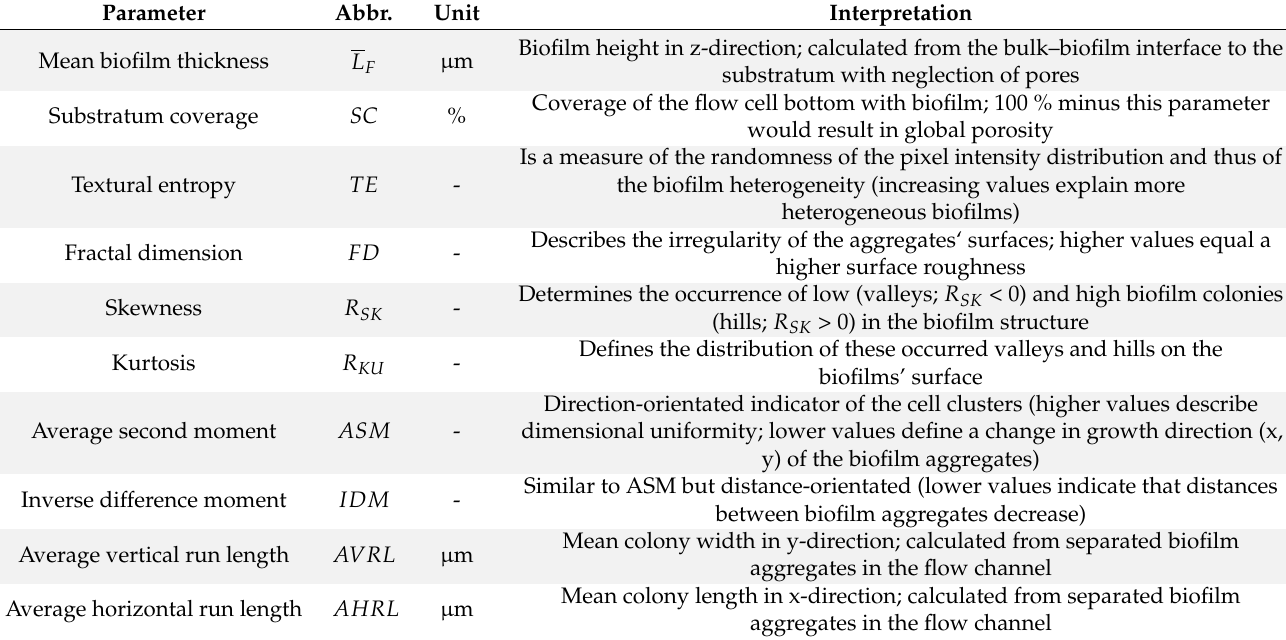
Table 2. Overview of all structural parameters used as well as their abbreviation, unit and interpreta- tion. Abbreviations: substratum coverage ( SC ), mean biofilm thickness ( L F ), textural entropy ( TE ), kurtosis ( R KU ) , skewness ( R SK ), fractal dimension ( FD ), angular second moment ( ASM ) , inverse difference moment ( IDM ) as well as average horizontal ( AHRL ) and average vertical run lengths ( AVRL )